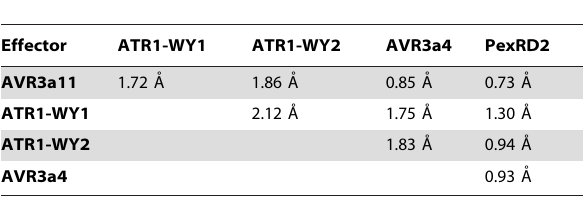
Table 1. Root mean square deviations (based on C a atoms) for overlays of the published RXLR effector structures (only the A-chains of ATR1 and PexRD2 were considered).